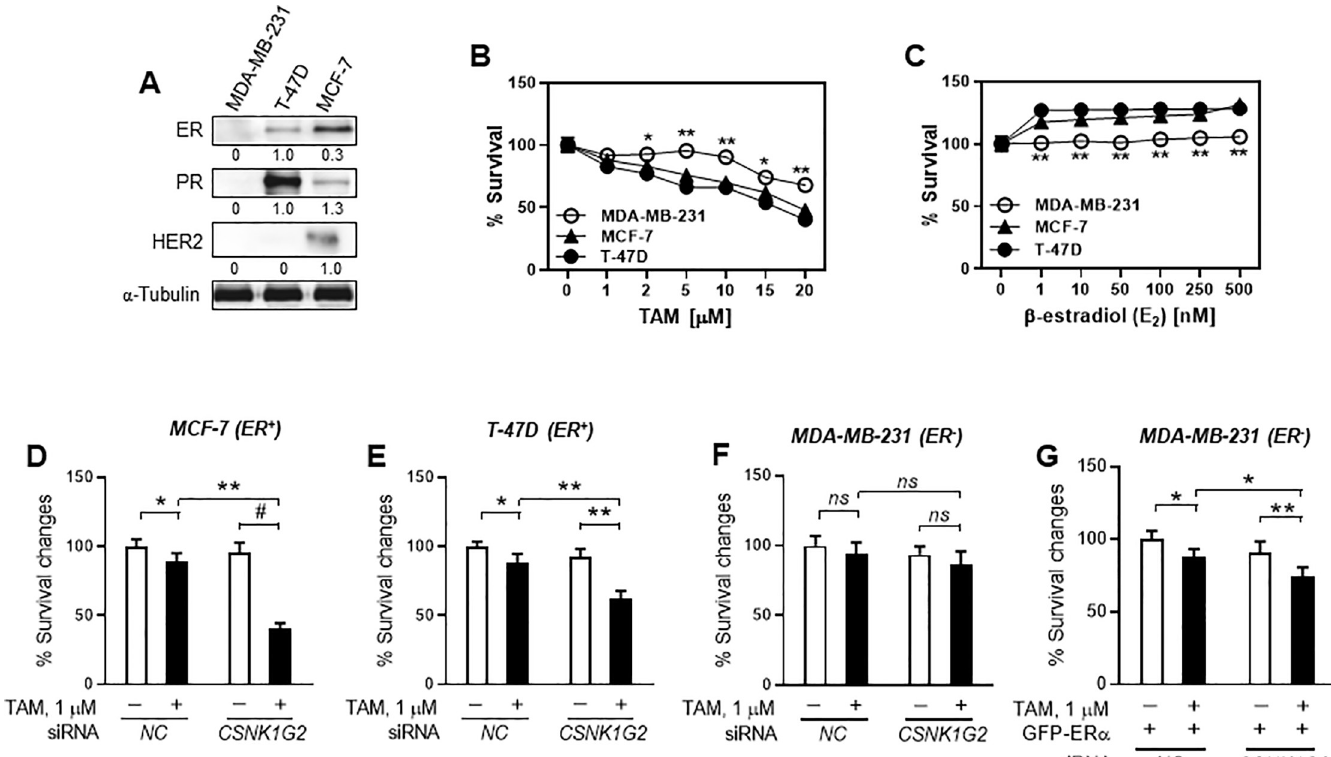
Fig 2. Different TAM sensitivity by CSNK1G2 knockdown in estrogen receptor (ER) + and ER - human breast cancer cells. (A) Immunoblots for ER, PR, and HER2 in different human breast cancer cell lines. ER + (MCF-7 and T-47D) and ER - (MDA-MB-231) breast cancer cell lines were prepared for western blotting. The expression pattern of different hormone receptors was determined. Protein expression levels were compared to expression levels of α -tubulin; each value under the blots indicates relative protein expression levels determined by densitometric analysis, unless specifically mentioned (mean (SD); n = 4). Dots denote ER + (MCF-7 and T-47D) or ER - (MDA-MB-231) breast cancer cells treated with different concentrations of (B) TAM and (C) β -estradiol (E 2 ). Bars denote (D) ER + MCF-7, (E) ER + T-47D, and (F) ER - MDA-MB-231 breast cancer cells treated with TAM after silencing with NC or CNSK1G2 siRNA. (G) ER - MDA-MB-231 also transiently transfected with GFP-C1 or GFP-ER α plasmid DNA as well as with NC or CSNK1G1 siRNA. Twenty-four hours after transfection, cells were treated with vehicle or 1 μ M TAM for 24 h. Cellular toxicity was then measured using the MTT assay (mean (SD); n = 4; � P < 0.05, �� P < 0.01, # P < 0.001 vs . each represented counterpart).